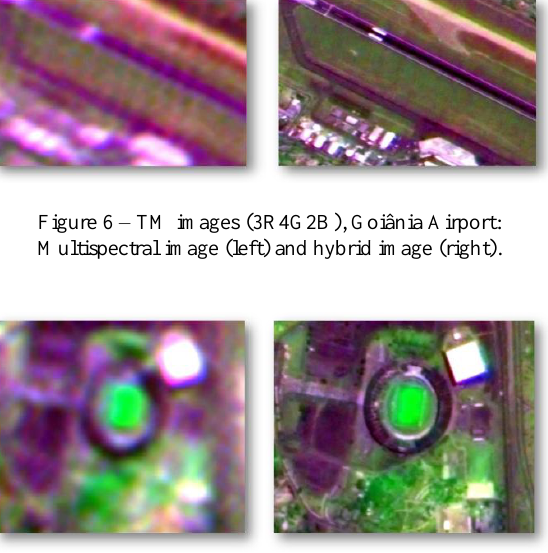
Figure 7 – CCD images (3R4G2B), Serra Dourada Stadium: (left) and hybrid image (right).